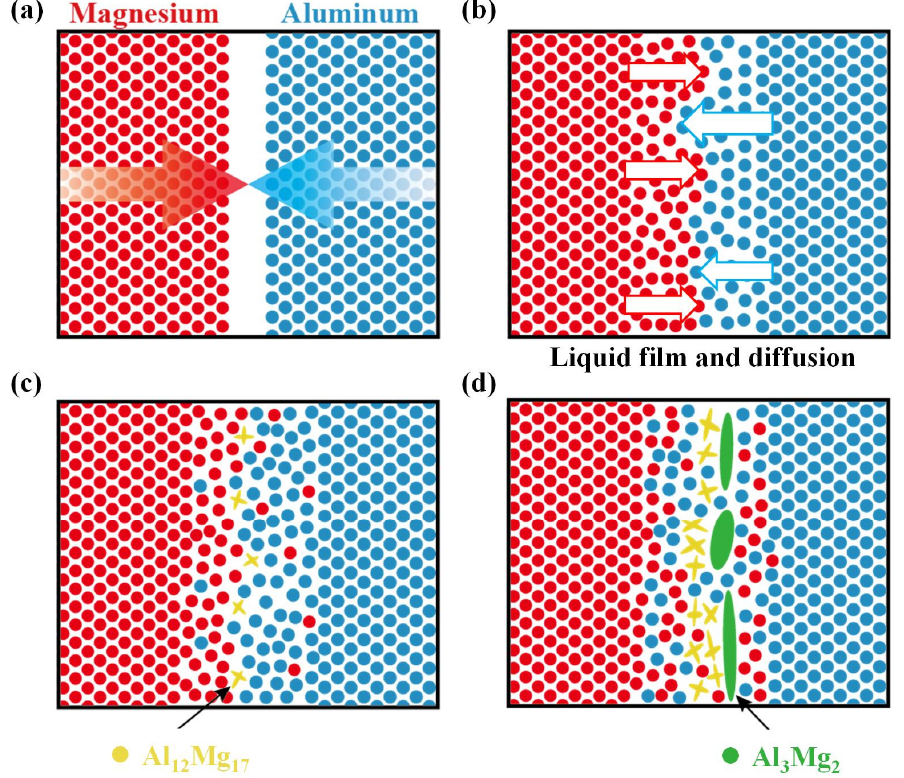
Figure 11. Schematic diagrams for the formation mechanism of IMCs: ( a ) the original interface, ( b ) liquid film and Al-Mg diffusion, ( c ) Al 12 Mg 17 , ( d ) Al 3 Mg 2. ( b ) liquid film and Al-Mg diffusion, ( c ) Al 12 Mg 17 , ( d ) Al 3 Mg 2